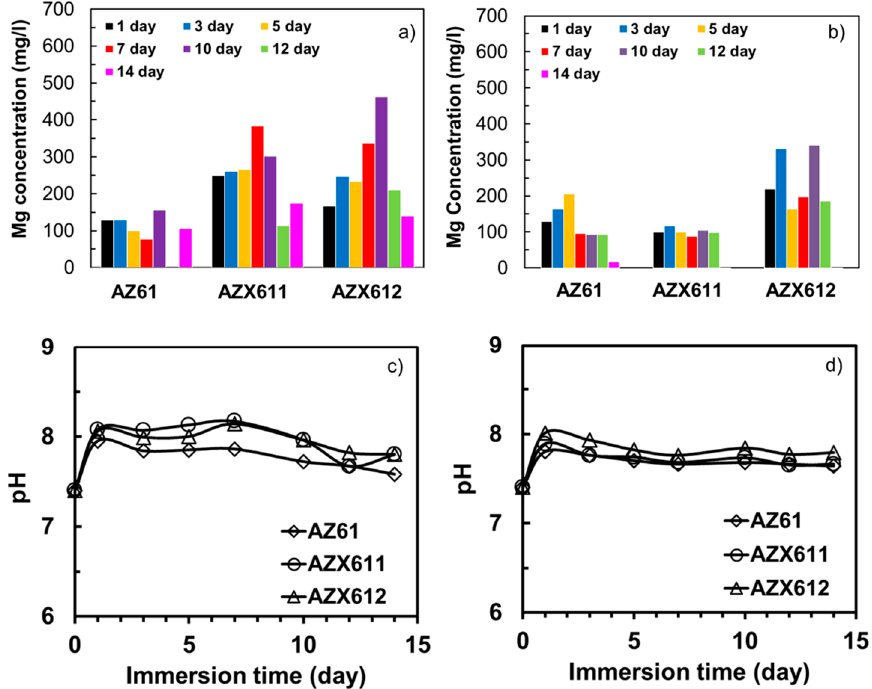
Figure 9. Concentration of Mg dissolved during immersion testing in SBF of the ( a ) substrates, ( b ) coated specimens, and the corresponding solution pH for ( c ) the substrates and ( d ) coated specimens.